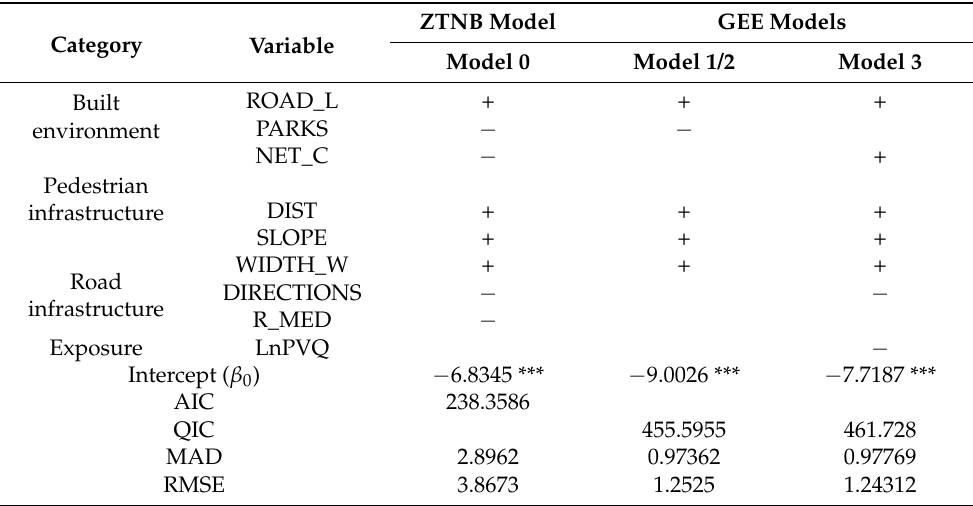
Table 5. Summary of the impact of significant